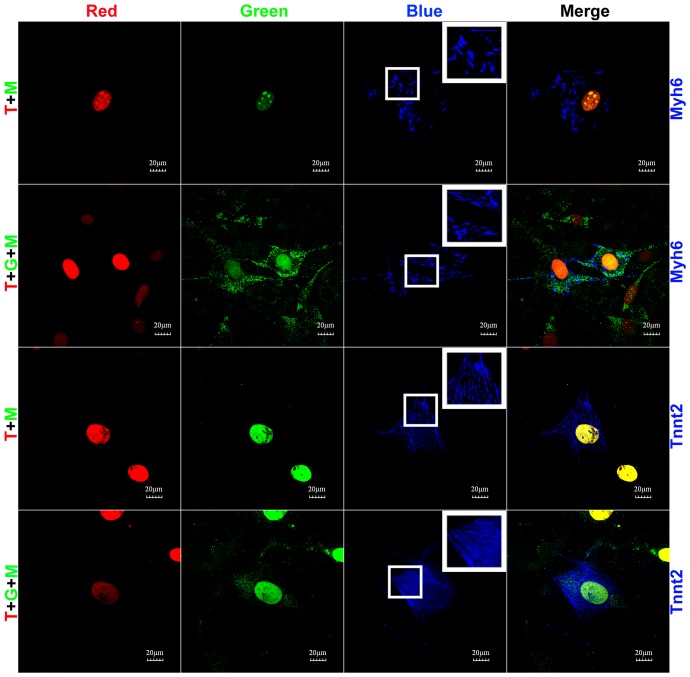
Tbx5+Myocd and Tbx5+Gata4+Myocd combinations induced Myh6 and Tnnt2 cardiac marker protein expression in 10T1/2 non-myoblastic cells.10T1/2 fibroblasts were infected with Nkx2-5, Tbx5, Gata4, Myocd lentivirus alone, or different combinations. LacZ lentivirus was used as control. Ten days after doxycycline induction, Myh6 and Tnnt2 protein expression was examined by incubating the cells with Myh6 or Tnnt2 primary antibody and was visualized by Alexa Fluor 350-conjugated secondary antibody. Only T+M and T+G+M combinations induced de novo Myh6 and Tnnt2 protein expression. Myh6+ and Tnnt2+ cell induction rates in designated cell populations were summarized in Table 1. Insets showed nascent fibril-like structures. Scale bar = 20 µm. N, Nkx2-5; T, Tbx5; G, Gata4; M, Myocd.